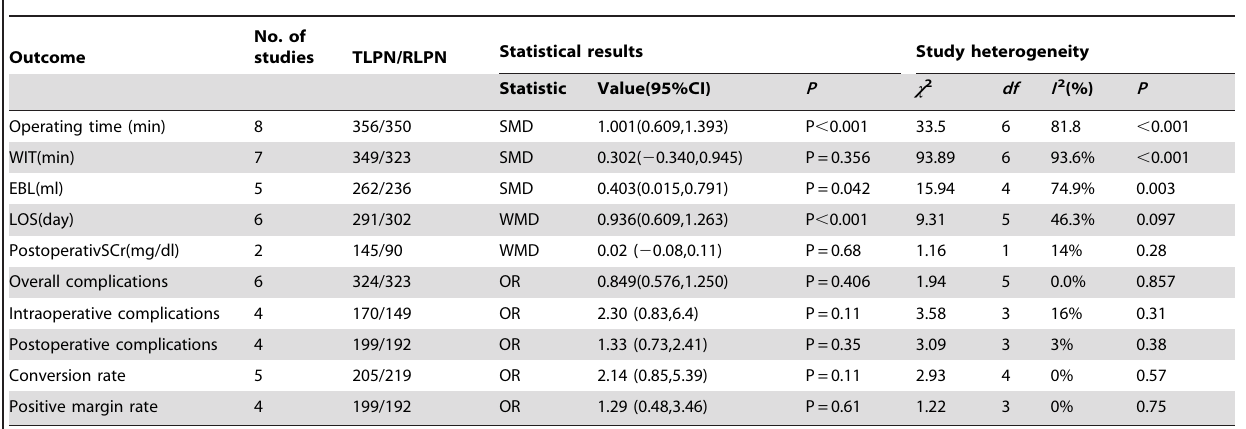
Table 2. Overall analysis of TLPN vs.